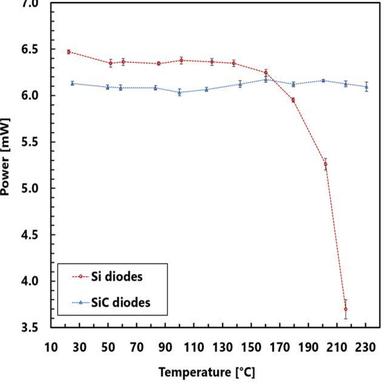
Rectified power output from piezoelectric device in function of temperature. Error bars represent a standard deviation from the consecutive power values calculated over six full periods at each temperature point. .